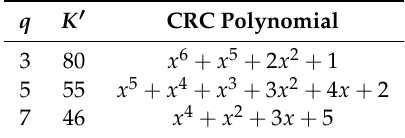
Table 2. Parameters of the non-binary polar codes.